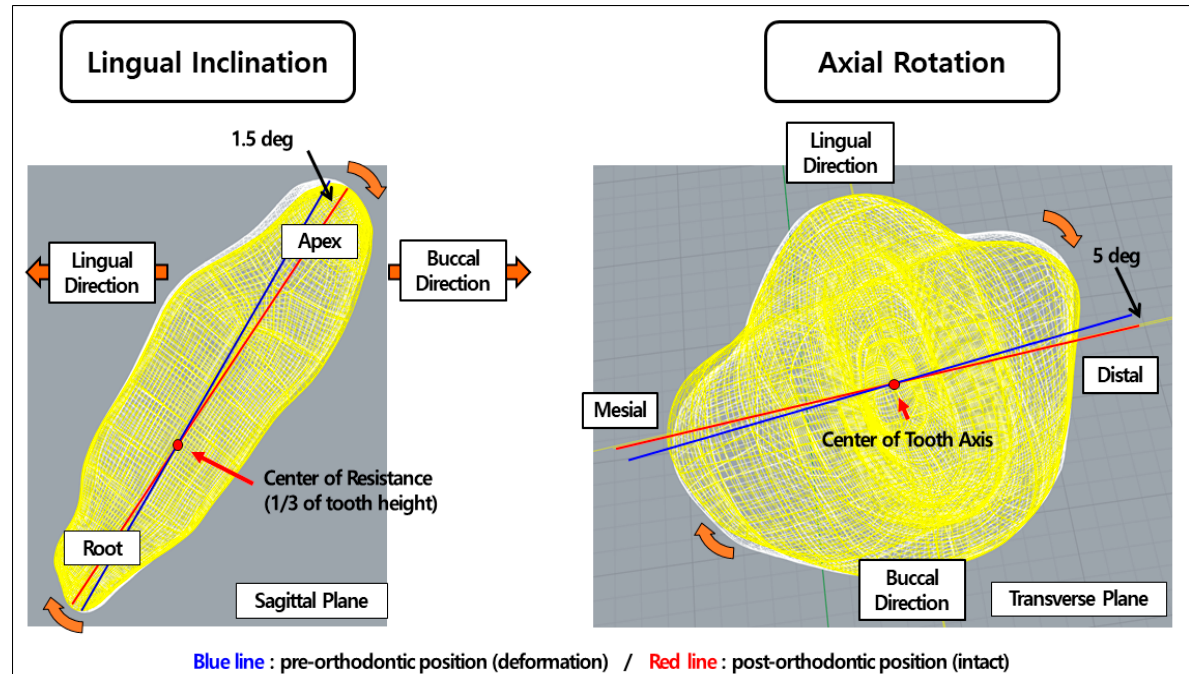
Figure 3. Deformation types and orthodontic treatment plans of central incisor applied to finite element analysis (FEA).